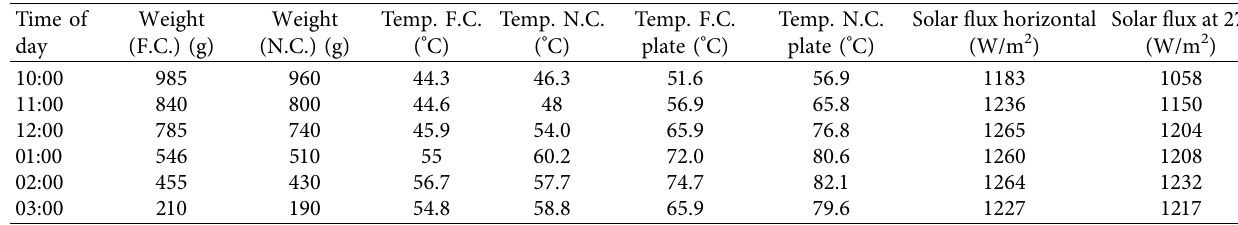
Table 9: Observation of coriander in a solar